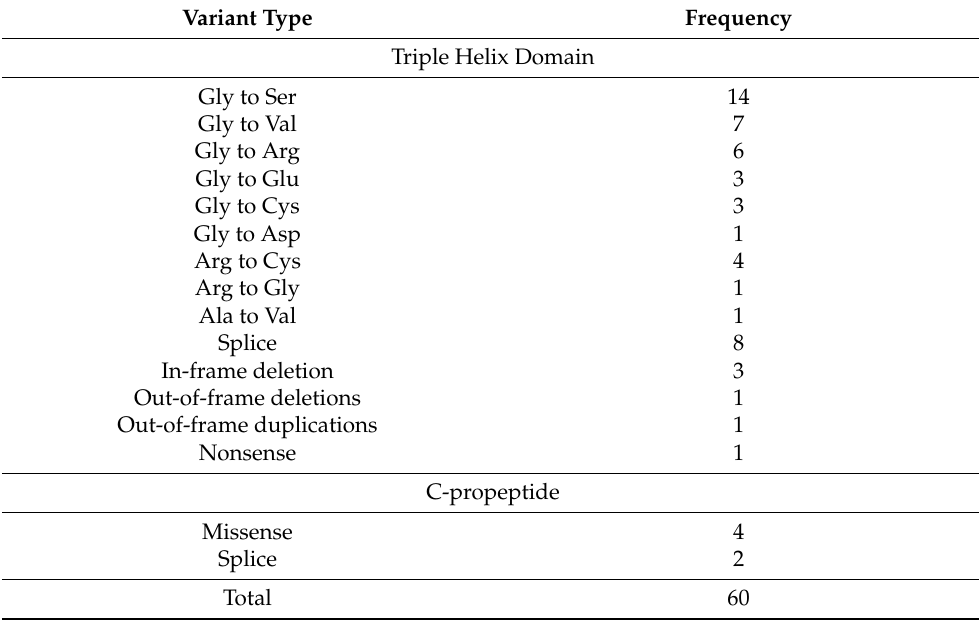
Table 1. Prevalence of different types of variants in the